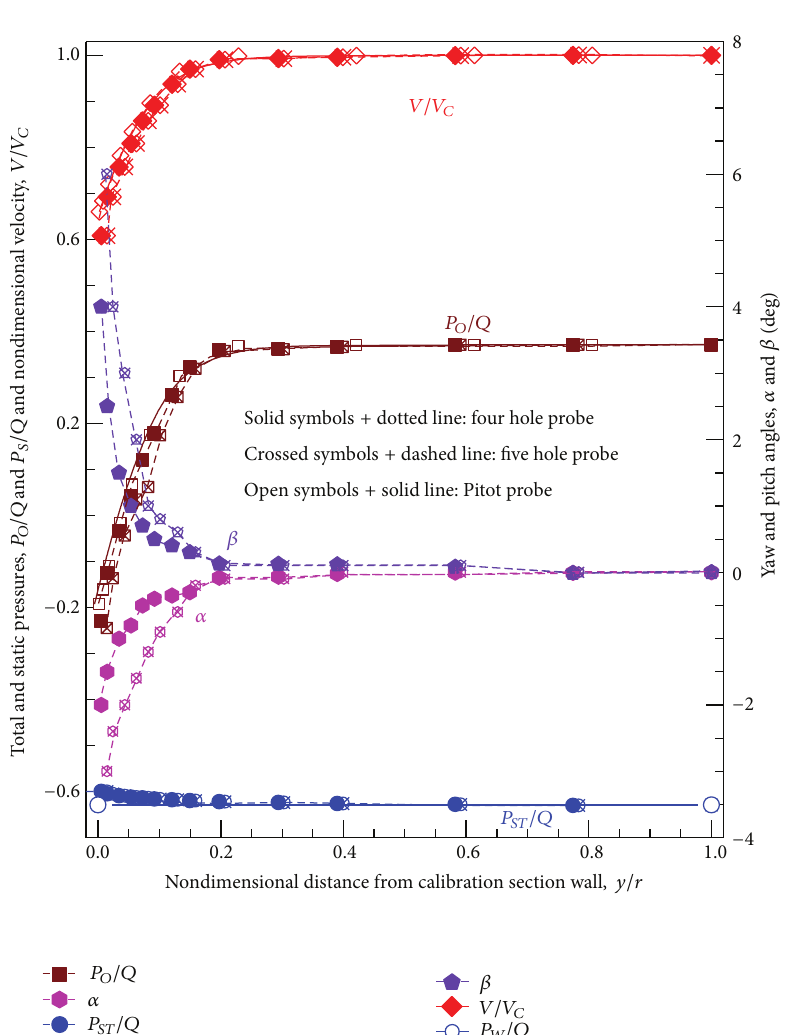
Figure 9: Comparison of probe measurements in the calibration section of the calibration